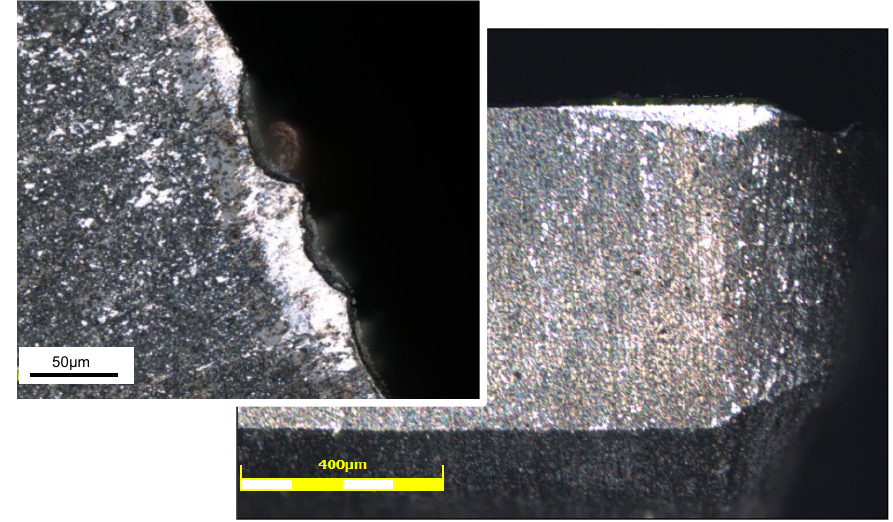
Figure 17. Wear observed on the cutting tool [22].